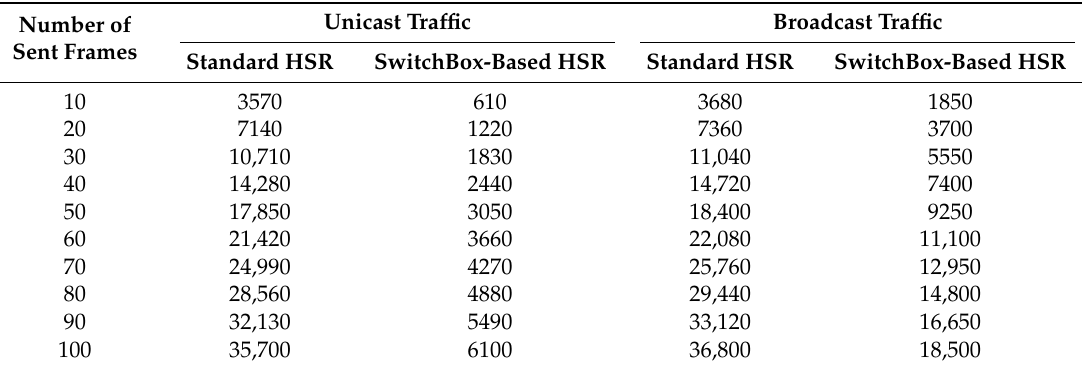
Table 3. Network traffic frames in Simulation